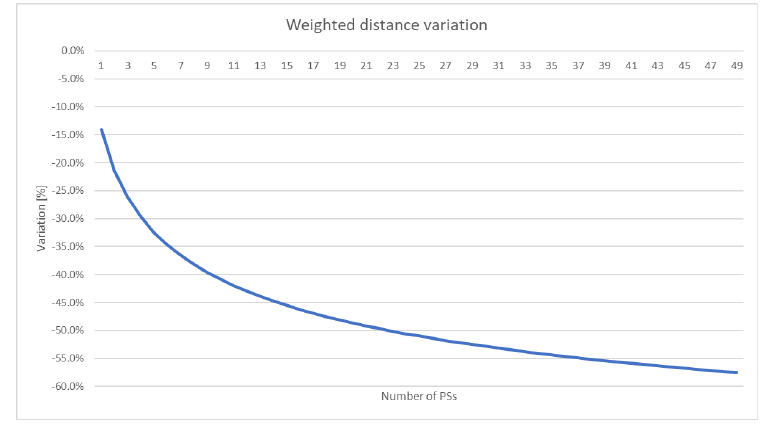
Figure 30. Trend of the fitness concerning the number of new